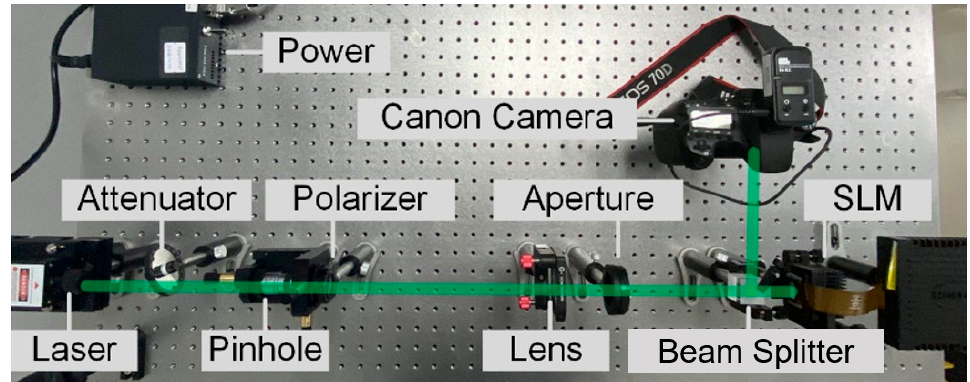
Figure 3. The phase-only holographic display system. In the experimental system, the illumination wavelength, pixel pitch, and resolution of the CGH are 532 nm, 3.74 µ m and 2000 × 2000, respectively. During the experiments, the camera is placed at shooting distances of 155, 160, 165, and 170 mm, respectively.